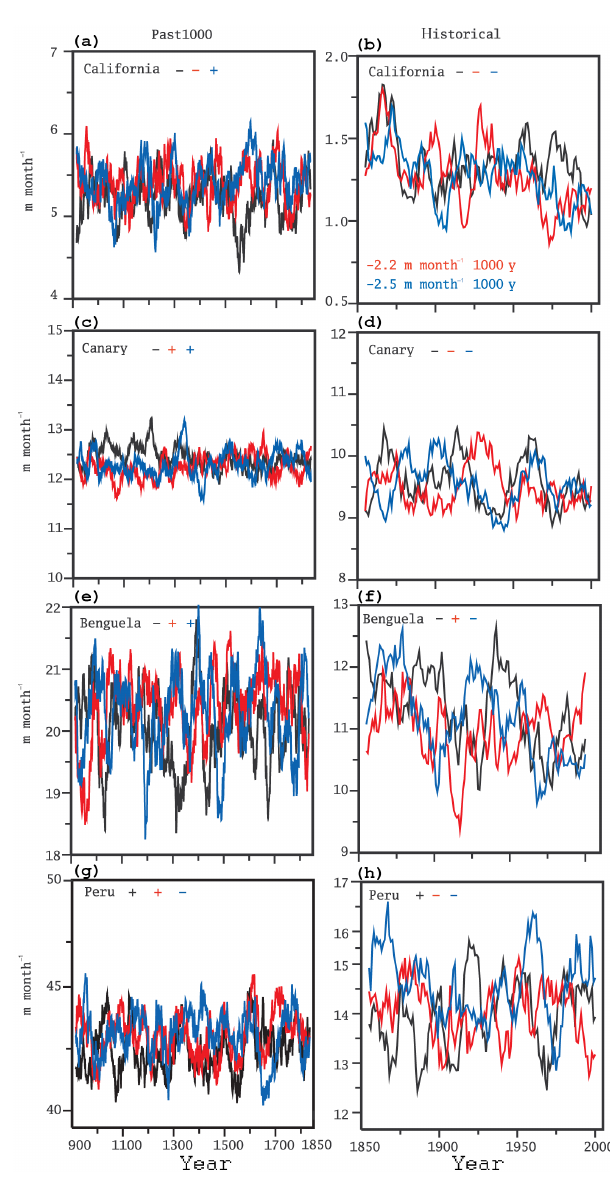
Figure 6. Time series of the simulated upwelling indices in each upwelling region simulated in two ensembles of climate simulations (three members each), denoted past1000 (900–1849) and historical (1850–2005), with the MPI-ESM model. The plus and minus signs in each panel indicate the sign of the long-term trend, their value being included whenever statistically significant. The series have been low-pass filtered, with a 30-year filter for past1000 and a 10- year filter for the historical